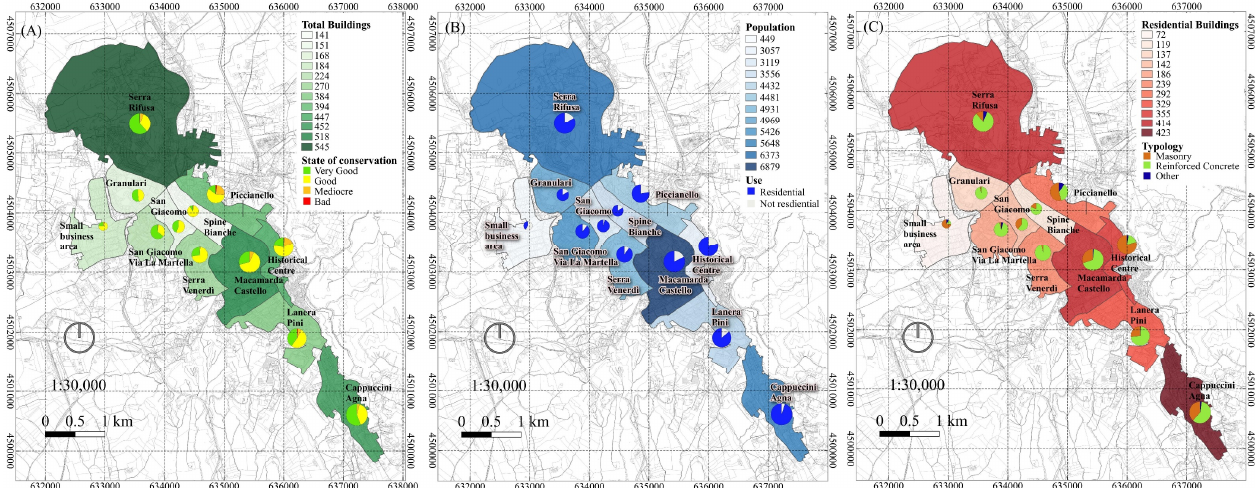
Figure 1. Spatial distribution of building characteristics: ( A ) building typology; ( B ) year of con- struction; ( C ) state of conservation; ( D ) height max (m). The black dashed line encloses the ‘SASSI’ area (not included in this study). The red dashed line delimits the urban area on which the study is focused.